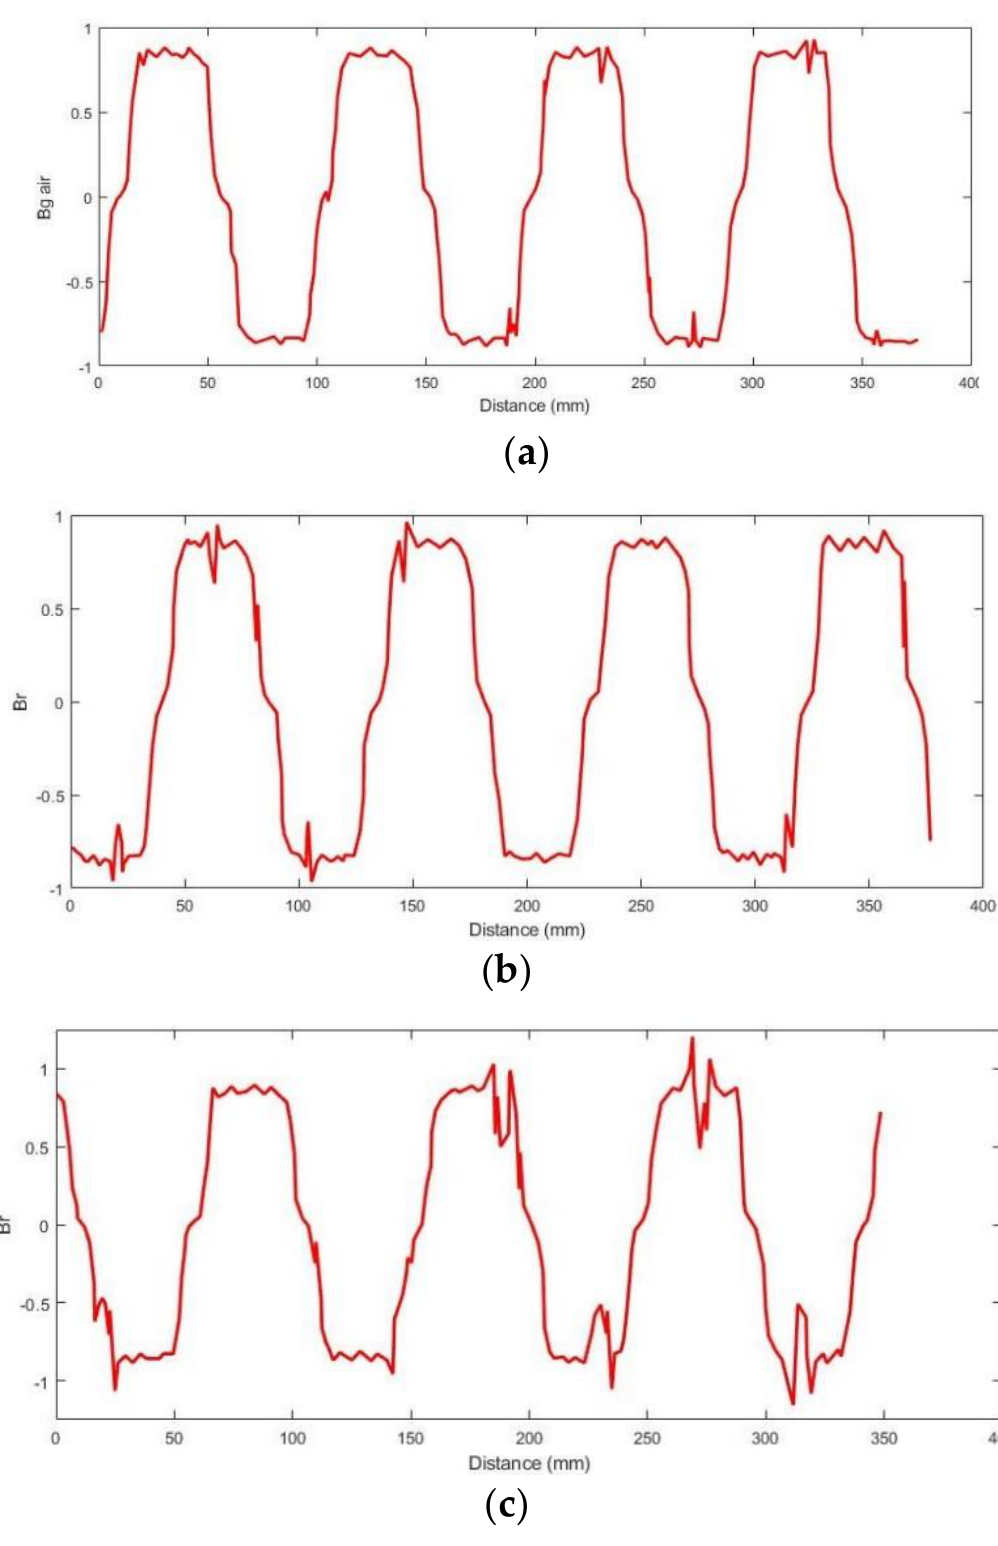
Figure 4. The flux density of air gap under no-load condition: ( a ) slot opening = 2 mm, ( b ) slot opening = 4 mm, and ( c ) slot opening = 7 mm.